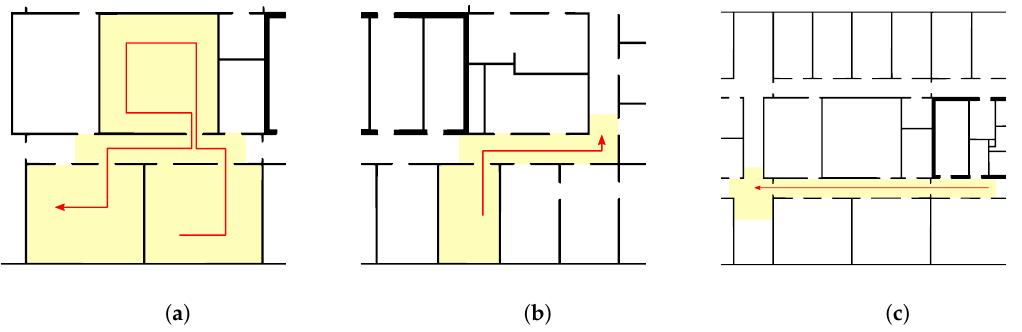
Figure 5. The three scenarios used for testing localization: Observed geometry is marked in yellow, and the path followed the red line. Red dots show selected points of recording used for testing.